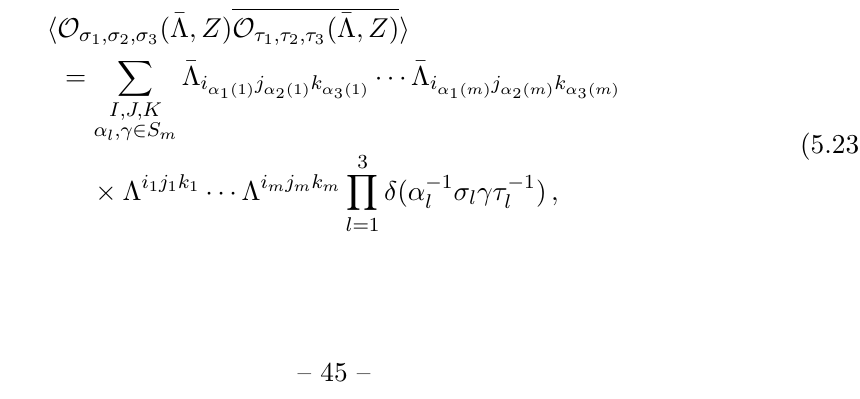
, τ − 1 and τ − 1 ) 1 2 3